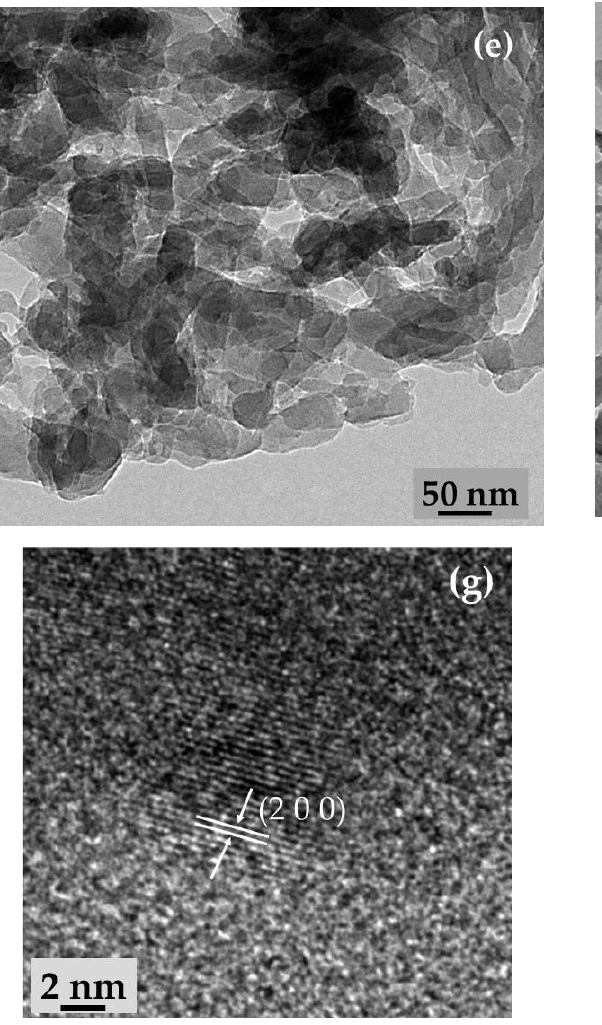
Figure 2. TEM images of ( a , b ) activated carbon particles; ( c – f ) semi-polycrystalline polyaniline- activated carbon (SPani-AC) composite; ( g , h ) high-resolution transmission electron (HR-TEM) micrographs of SPani-AC composite showing crystallographic phases.